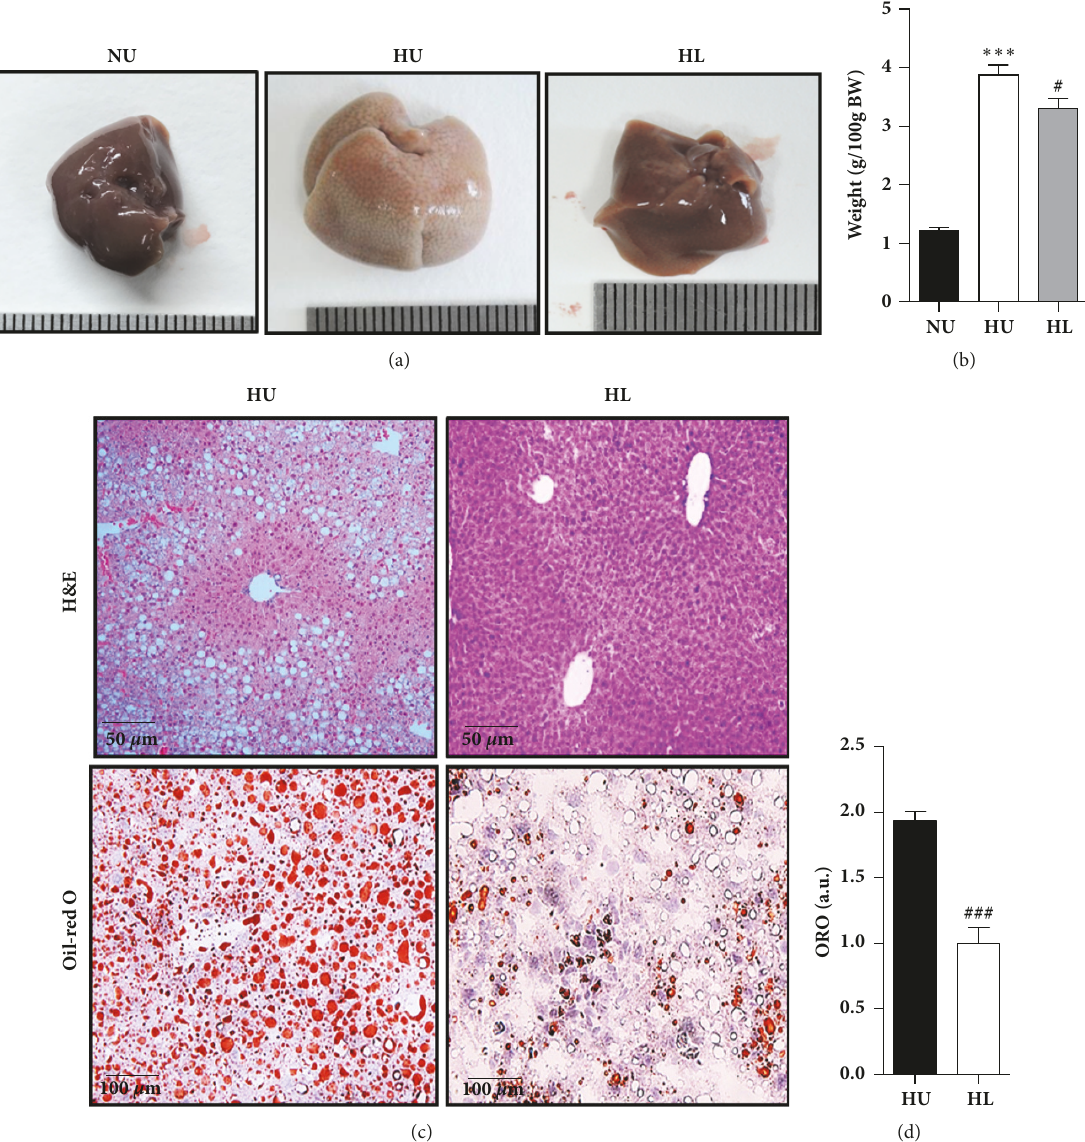
Figure2:LobeglitazonetreatmentameliorateshepaticsteatosisinHFD-fedmice.(a)RepresentativeimagesofliversofNCD-fedmicewithout treatment (NU), HFD-fed mice without treatment (HU), and HFD-fed mice with lobeglitazone treatment (HL) after 12 weeks of a HFD. (b) Weight of the livers (g/100 g body weight) of NU (black bar), HU (white bar), and HL (black gray bar). (c) Representative images of hematoxylin and eosin staining and Oil Red O staining of liver sections of HFD-fed mice without treatment (HU) and HFD-fed mice with lobeglitazone treatment (HL). (d) Digital image analysis (DIA) quantification of Oil Red O stained sections. a.u., arbitrary units. Data are expressed as means ± SEM. ∗ p < 0.05, ∗∗ p < 0.001, and ∗∗∗ p < 0.0001, NU versus. HU group. # p < 0.05, ## p < 0.001, and ### p < 0.0001, HU versus. HL